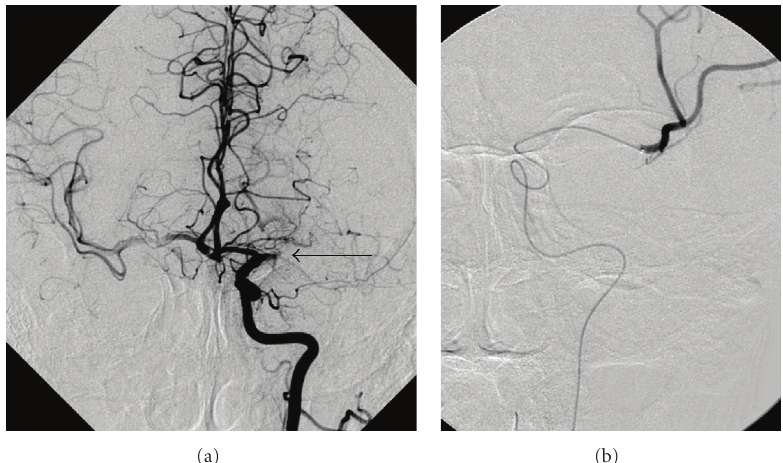
Figure 2: (a) Diagnostic angiogram (left internal carotid artery injection, anteroposterior projection) shows (arrow) the occlusion of the horizontal segment of the left middle cerebral artery (MCA). (b) Coaxial catheterization with a microcatheter and stirable microguidewire entering the occluded vessel, traversed the occluded segment of the left MCA. With the contrast, the peripheral MCA is visualized.